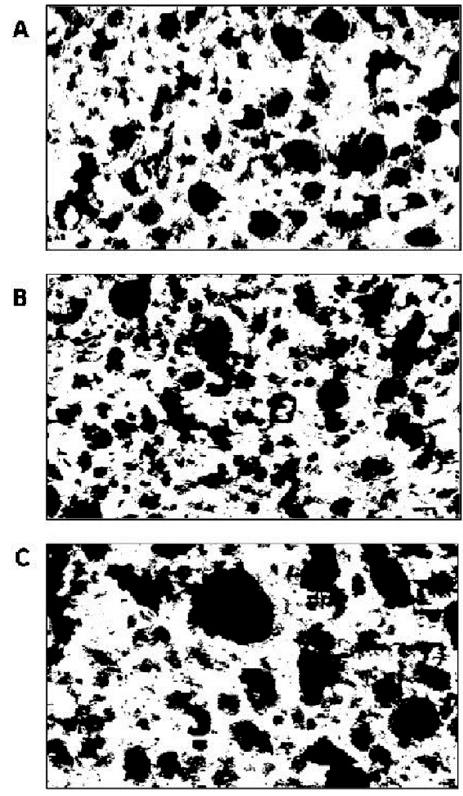
Figure 3. Representative digital images of experimental breads B C2.27 ( A ), B C5.7 ( B ) and B CTR ( C ), showing the computed binary results from gray level thresholding at the two-cluster.